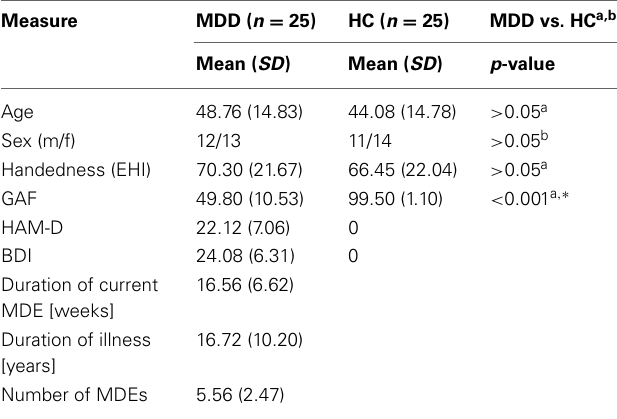
Table 1 | Demographic and clinical